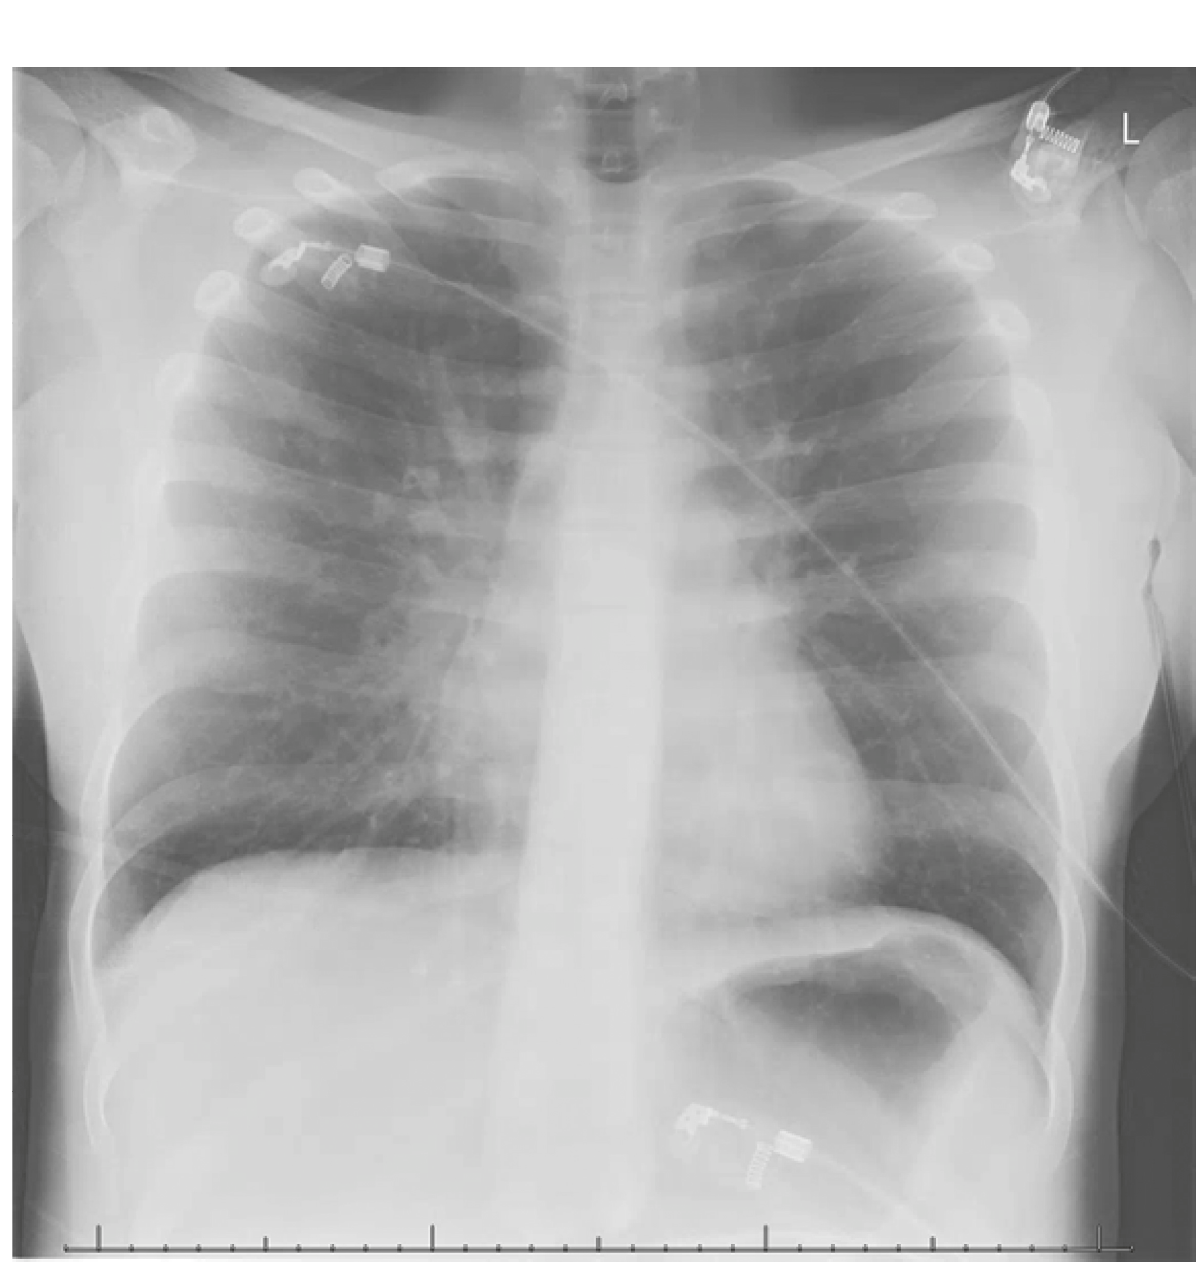
Figure 2: X-ray PICU